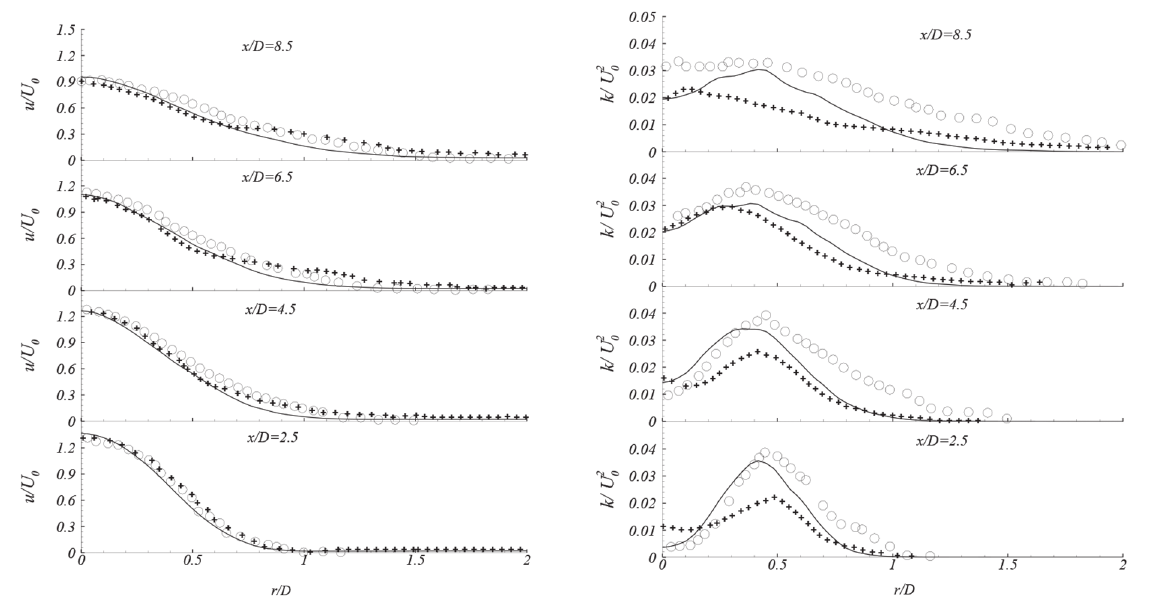
Figure 10 - Radial variation of average velocity and kinetic energy profiles for the cold-flow F3 jet. The solid lines are results of the present work, the plus, (+), symbols are numerical results obtained by Yilmaz (2008) and the circles are experimental results of Chen et al.